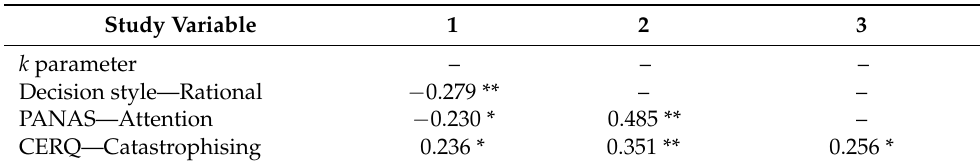
Table 2. Significant correlations between the cognitive and affective individual predictors and delay discounting scores ( k parameter) in the domain of gains.